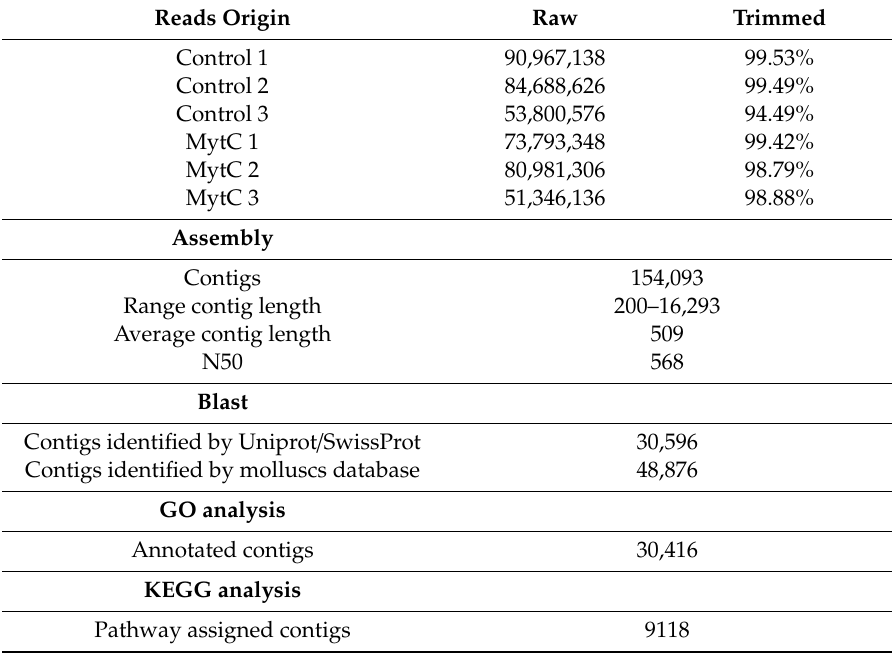
Table 1. Summary of the transcriptome bioinformatics